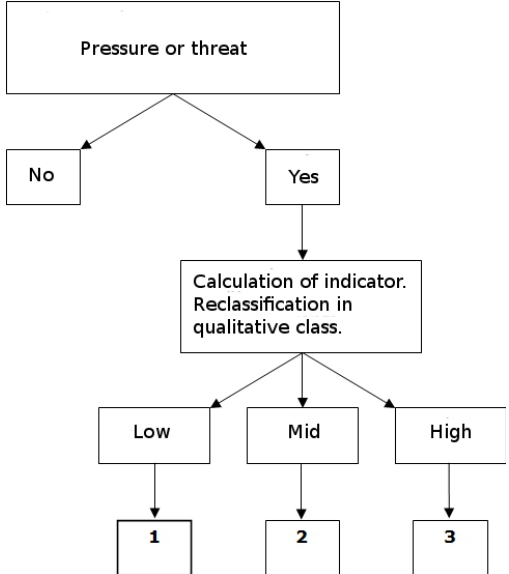
Figure 2. Assessment of the